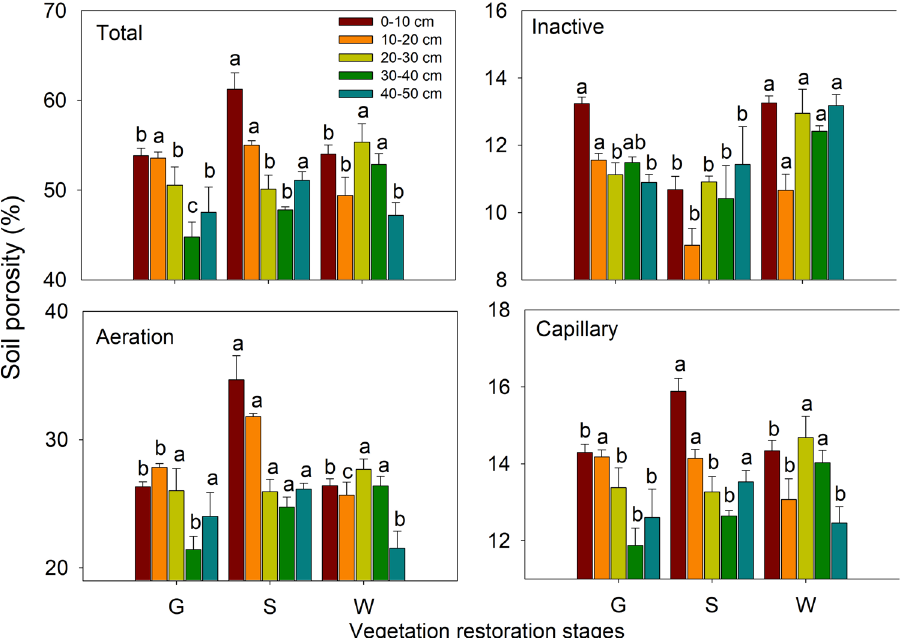
Figure 8. Soil total porosity, inactive porosity, aeration porosity and capillary porosity in the different soil layers at different vegetation restoration stages (see Table 1). The values are in the form of means ± SEs, and the sample size (n) is 5. The different lowercase letters above the bars indicate significant differences within a soil layer among the different vegetation restoration stages ( P < 0.05).